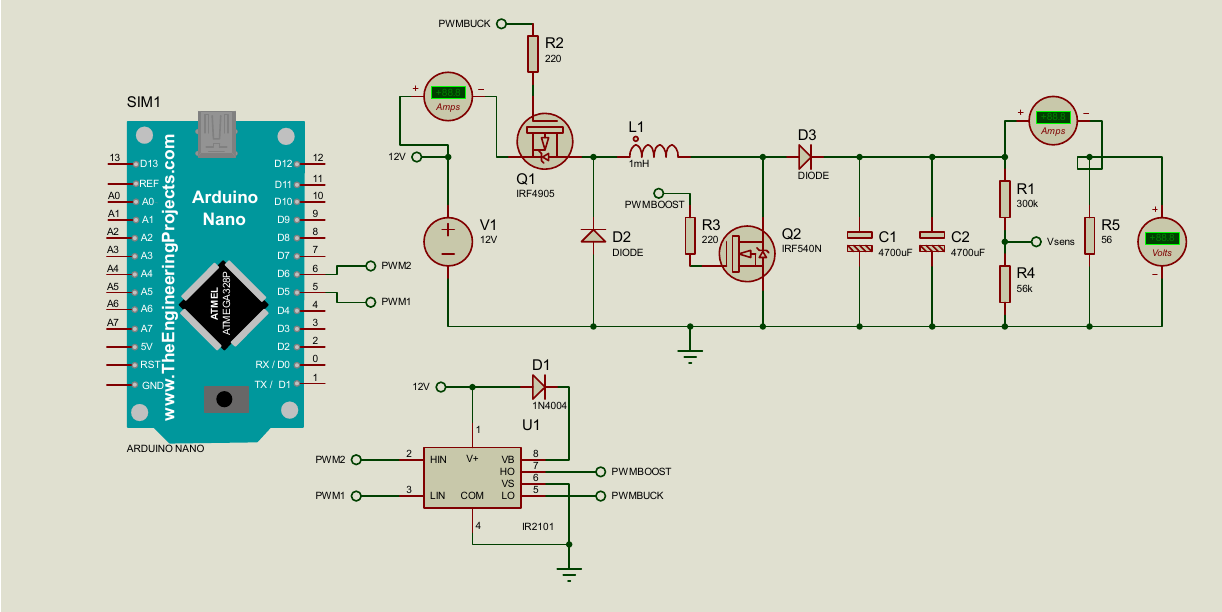
Figure 4. Buck-boost converter simulation circuit.